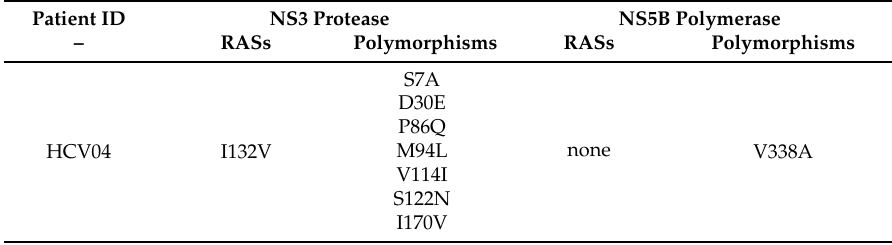
Table 3. Nonsynonymous substitutions detected for NS3 and NS5B target region in HCV isolates from SVR